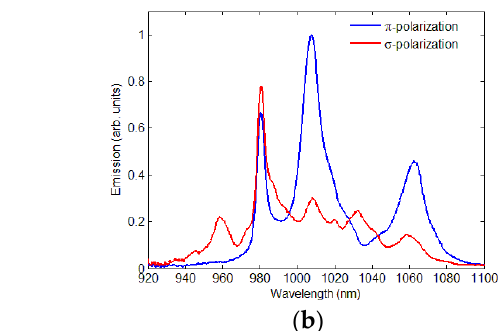
Figure 7. (a) Simulated Yb profile in LiNbO 3 for the in-diffusion of two 22 nm thick layers evaporated under ±60° and in-diffused for 216 h at 1125 °C. (b) The Yb profile in x-direction in the middle of the ridge (red line). The results for a plane layer of Yb diffused in from the surface only are included as a blue line. (c) Simulated (left) and measured (right) intensity distribution for the fundamental mode at